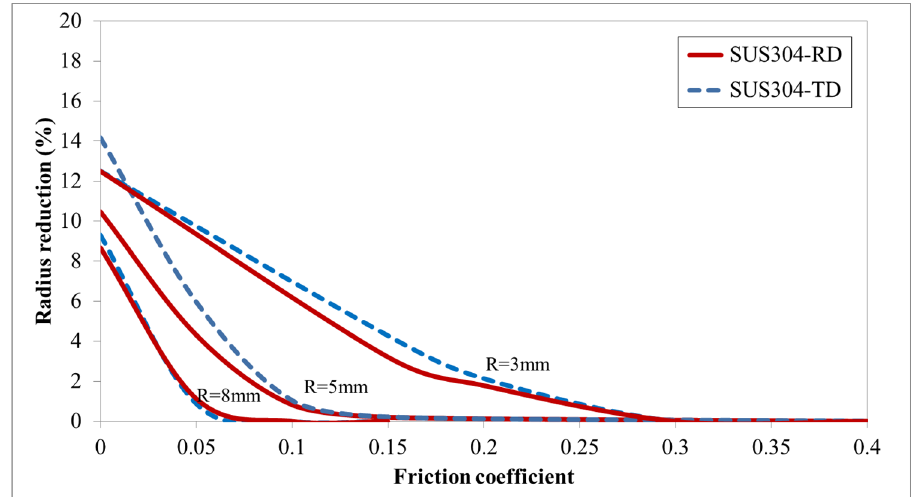
Figure 15. Variation of radius reduction versus friction coefficient.